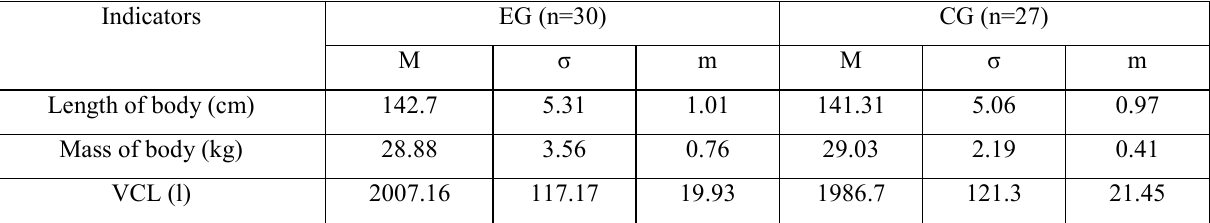
Some initial indicators of physical condition of 9-11 years old karatekas